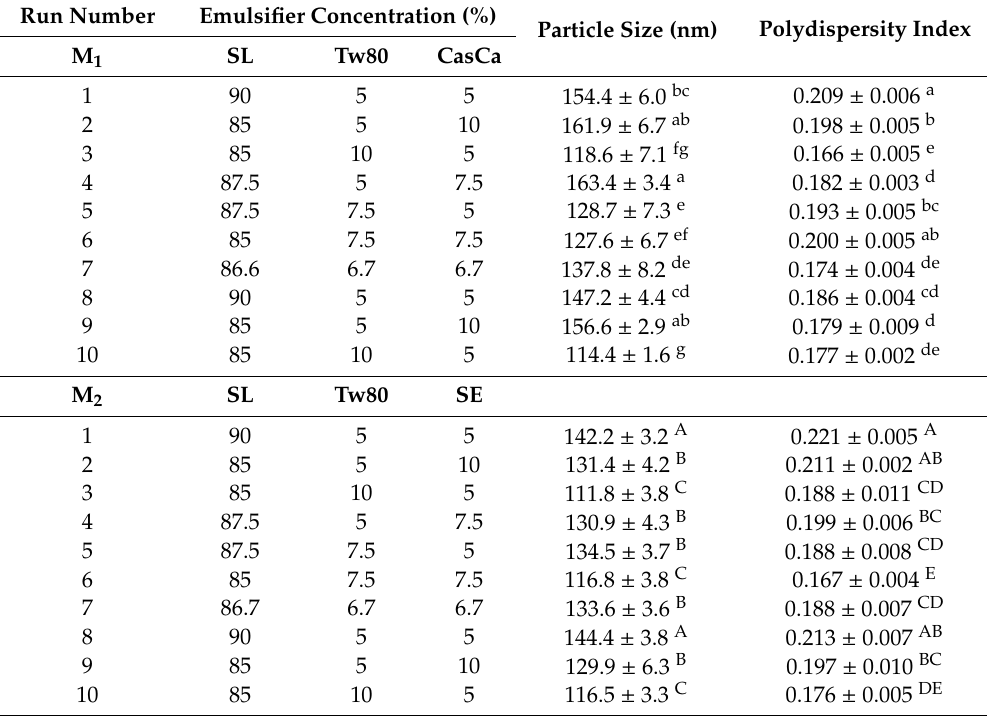
Table 2. Particle size and polydispersity index of nanoemulsions correspondent to each run of experimental design for two emulsifier mixtures studied.